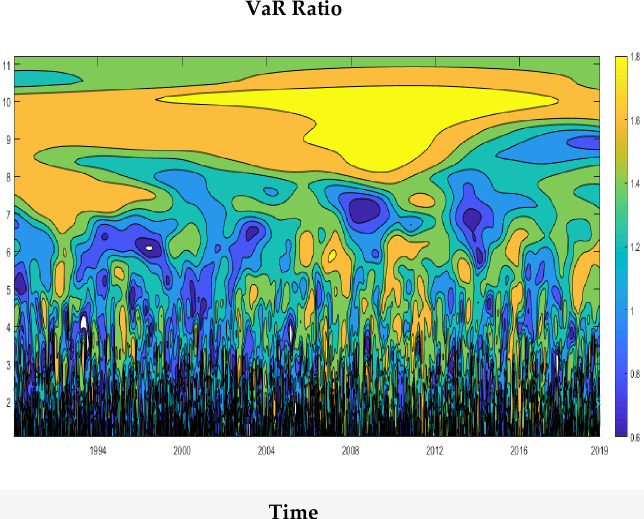
The ratio of the Asian emerging multi-country portfolio variances plot.